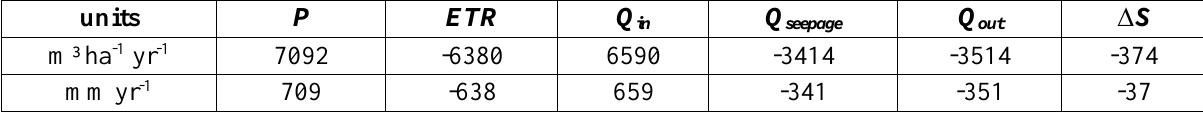
Table 2. Water balance components of the Sphagnum farming trial for the hydrological year 2013. units P ETR Q